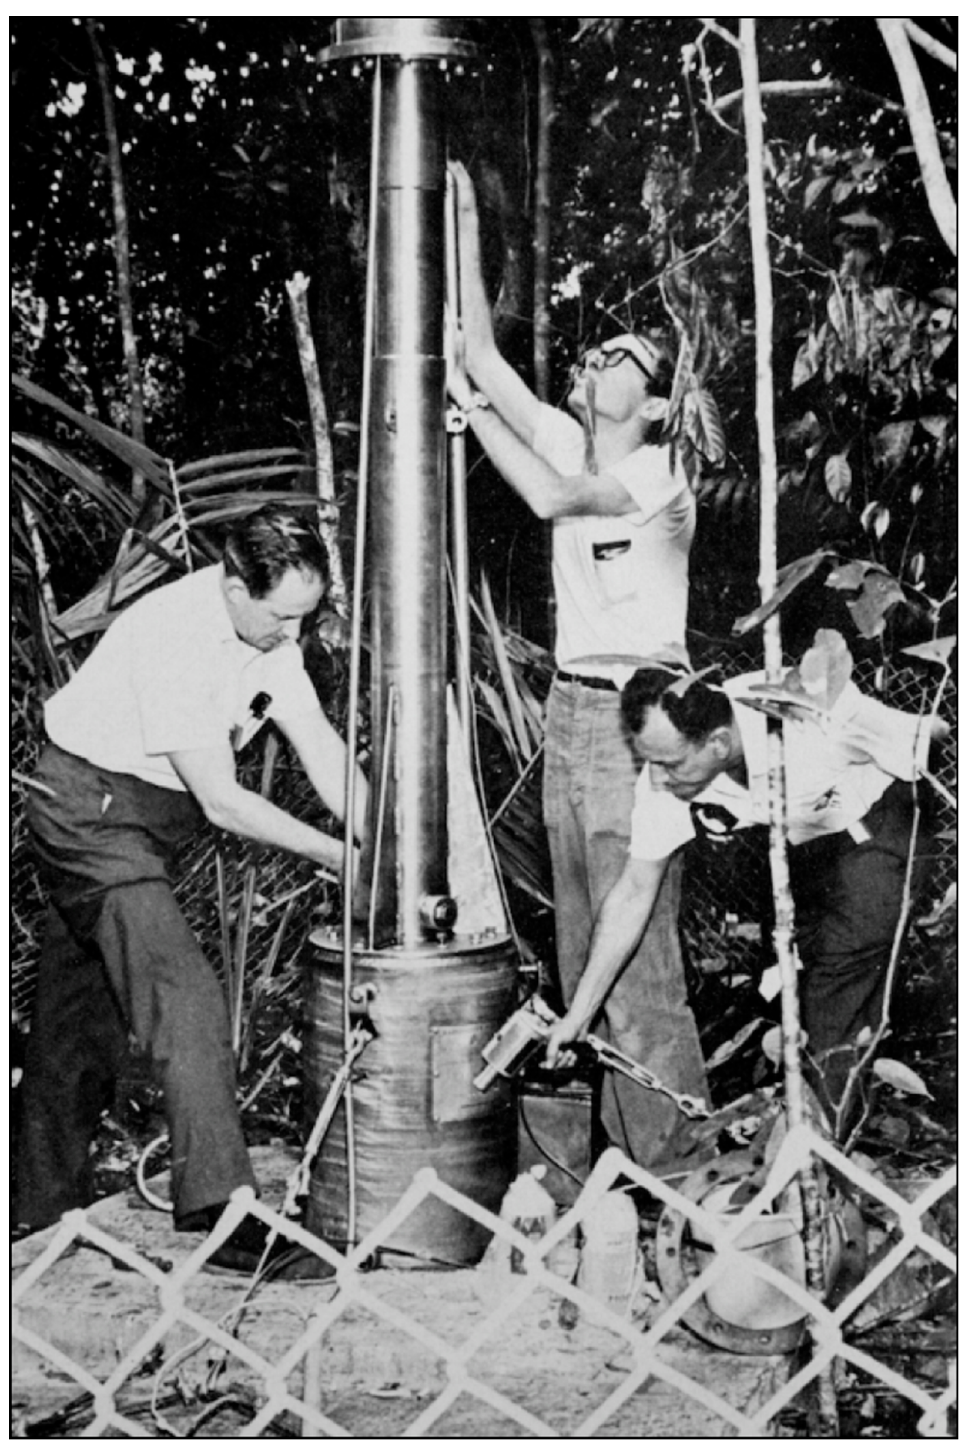
Figure 2. Scientists installing the base and casing for the Cesium radiation source in the Luquillo Experimental Forest. Photo reproduced from [53].